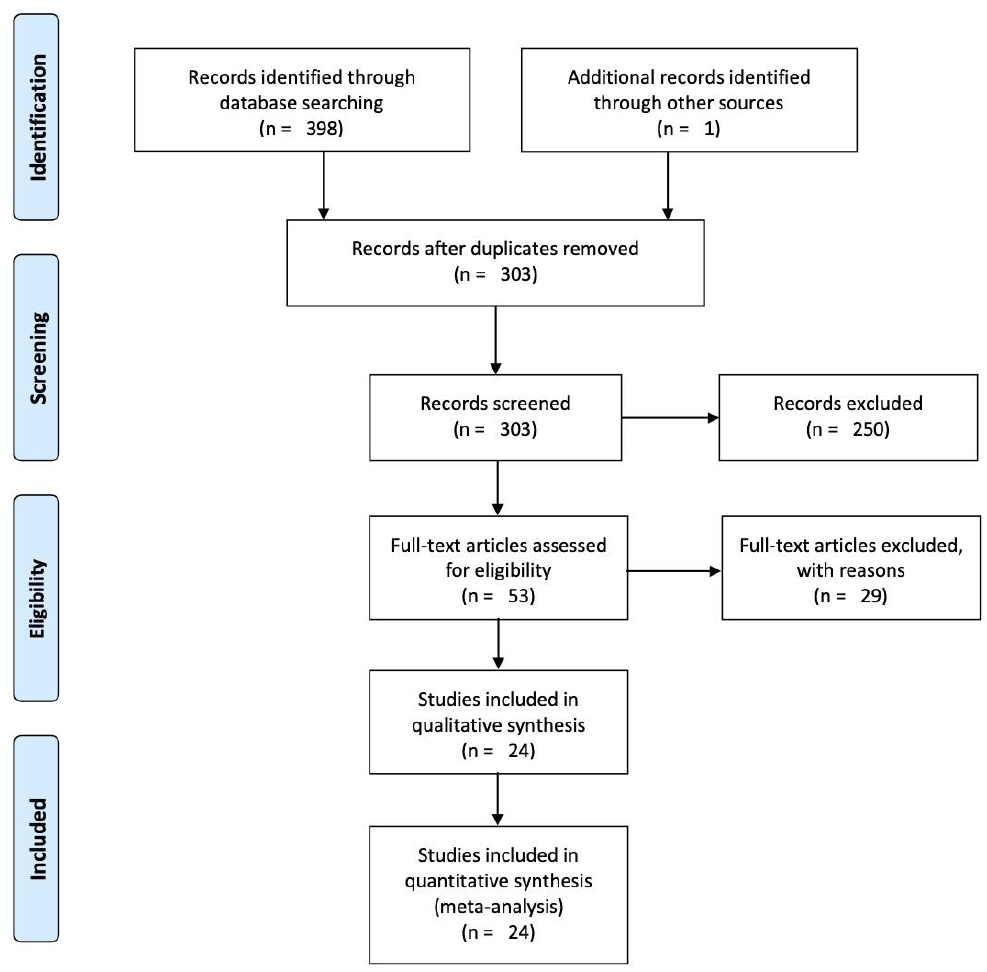
Figure 1. Flow diagram to show study-selection process.